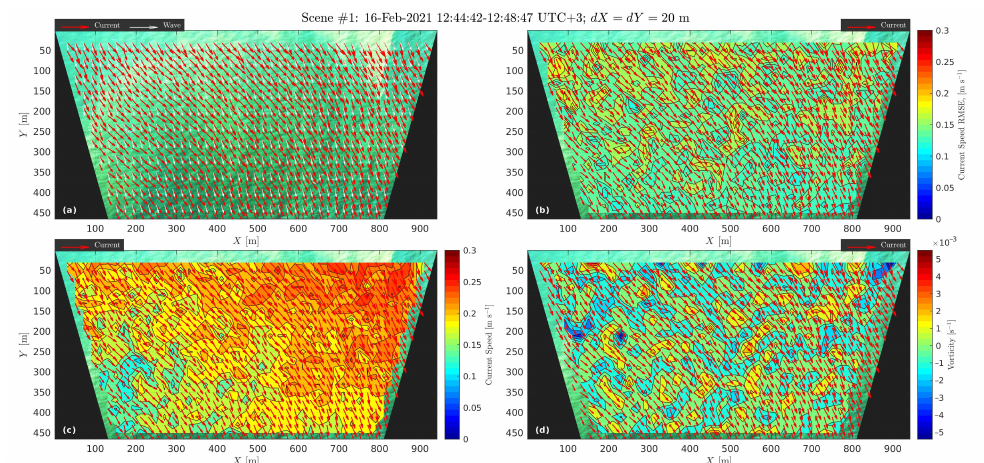
Figure 3. Scene #1: ( a ) sea surface current (SSC) and wave quiver maps; ( b ) SSC root-mean-square error (RMSE); ( c ) SSC speed; and ( d ) SSC vorticity.